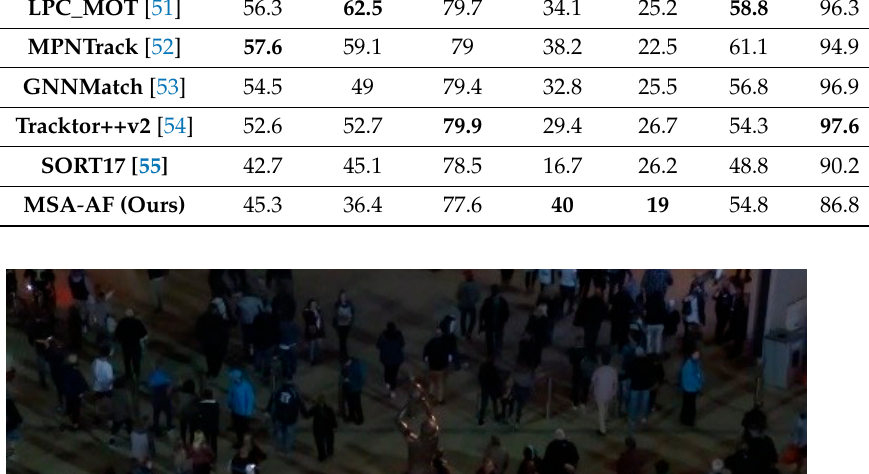
Table 5. Performance comparison with five state-of-the-art algorithms on MOT20.